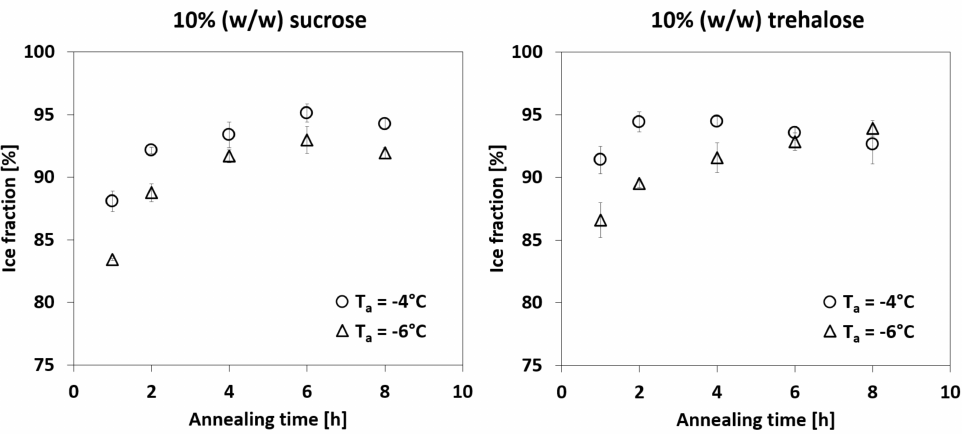
Figure 5. Ice crystal fraction as a function of annealing time for different annealing temperatures of 10% ( w / w ) sucrose and trehalose solutions. Standard deviations were calculated from